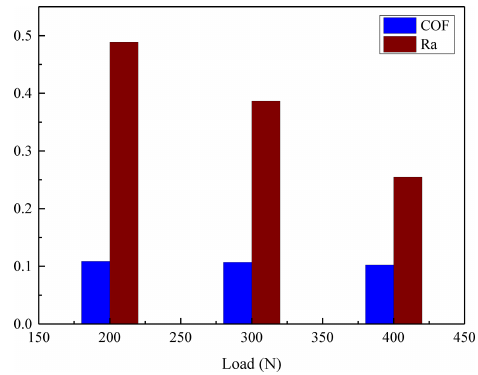
Figure 10. The COF of the cylinder liner under different loads.